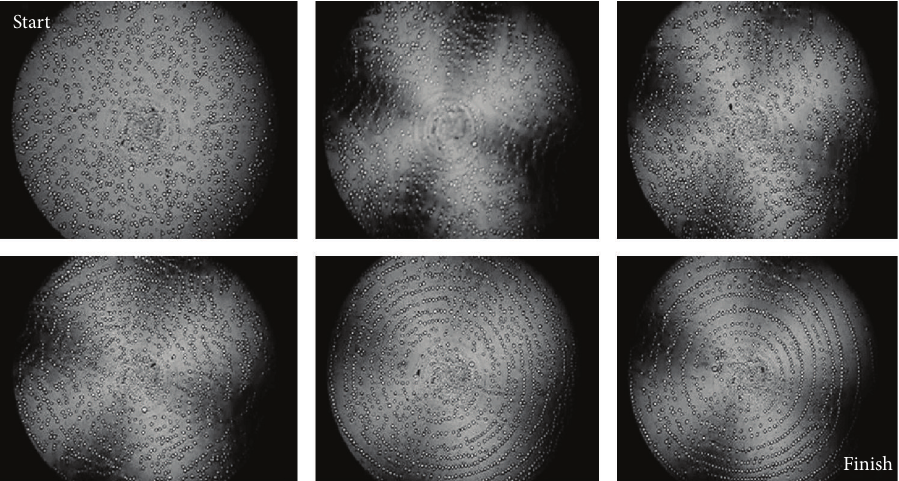
Figure 11: Frames of a movie demonstrating evolution of small particles distribution under shearing in poly(isobutylene) filled with PMMA microspheres (80 𝜇 m in diameter). Frames from left to right and from upper to lower images correspond to 0, 2, 4, 8, 16, and 32 s, respectively. The pictures were made under polarized light and the Maltese cross is seen due to anisotropy of a sheared polymer matrix. possible at the Weissenberg Number of the order of 5-6 that corresponds to the well-known condition of the flow-to- rubbery